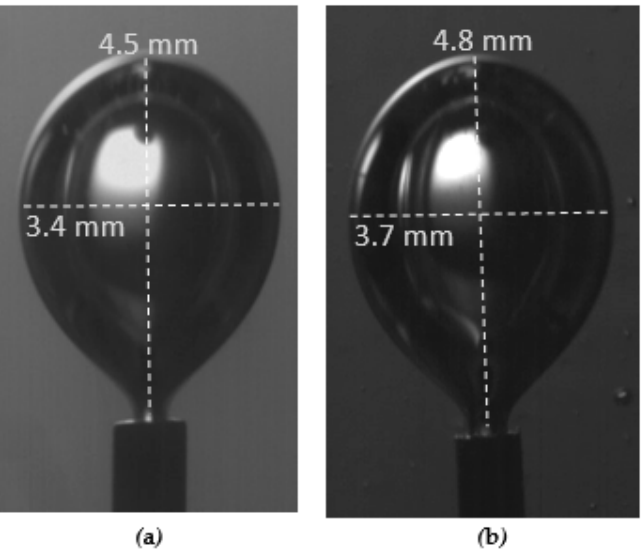
Figure 8. Bubble size comparison during release time t 0 from the tube for ( a ) G1, ( b ) G2 (Q = 0.81 × 10 − 6 m 3 /s).